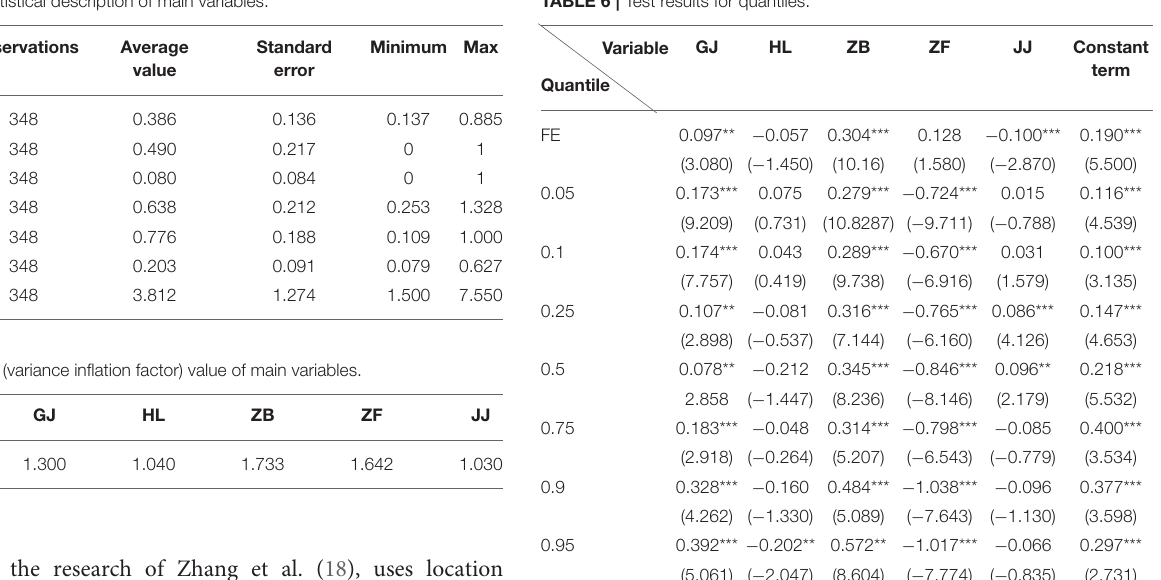
TABLE 6 | Test results for